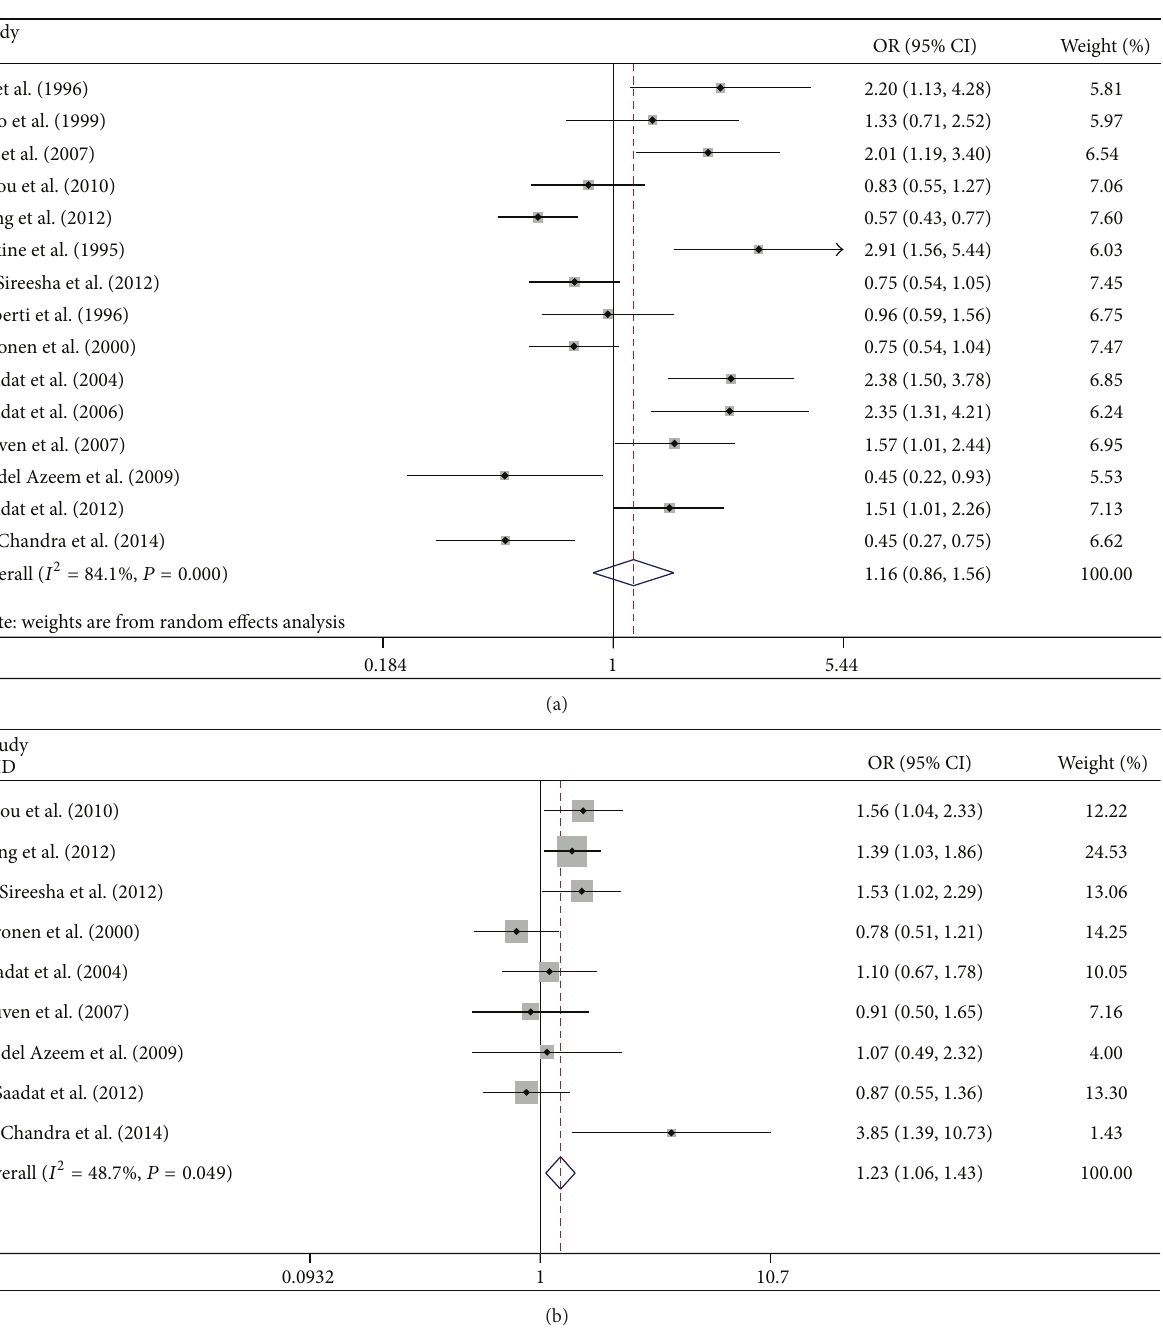
Figure 2: Forest plot of the association between GSTM1 / T1 null genotype and age-related cataract (ARC). (a) Forest plot of the association between GSTM1 null genotype and ARC. (b) Forest plot of the association between GSTT1 null genotype and